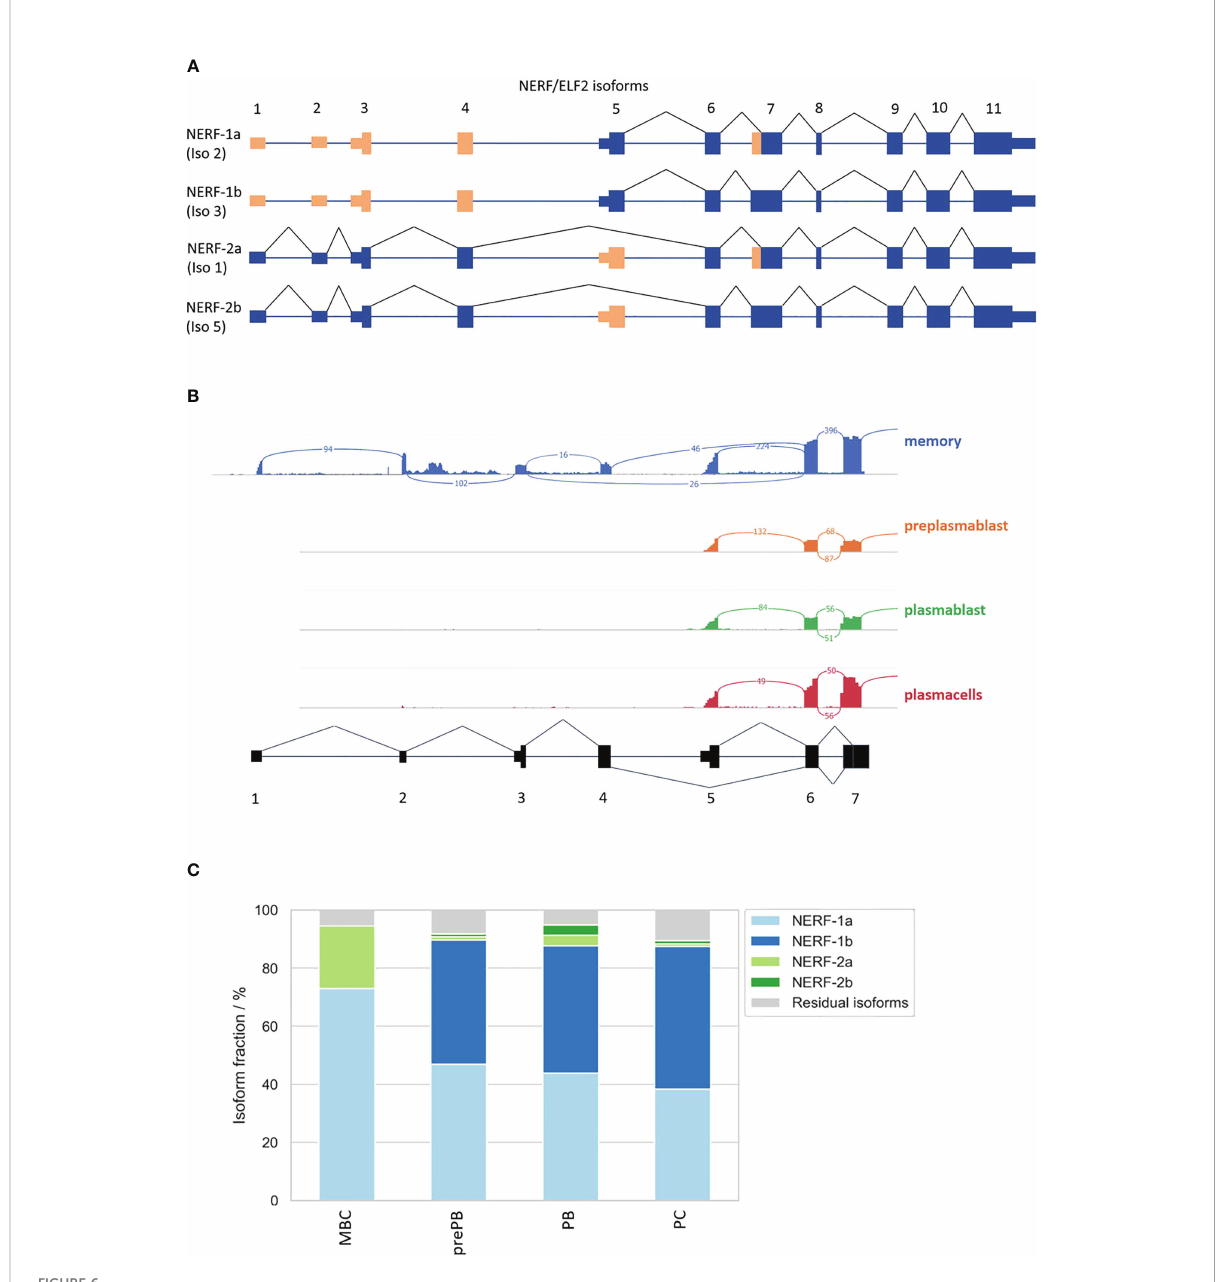
FIGURE 6 Alternative splicing of the transcription factor NERF/ELF2 . (A) Possible NERF/ELF2 isoforms according to USCS genome browser and UniProt. (B) Sashimi plot of NERF/ELF2 transcript in MBC, prePB, PB, and PC. (C) Stacked barplot of NERF/ELF2 isoforms in B-Lymphocyte